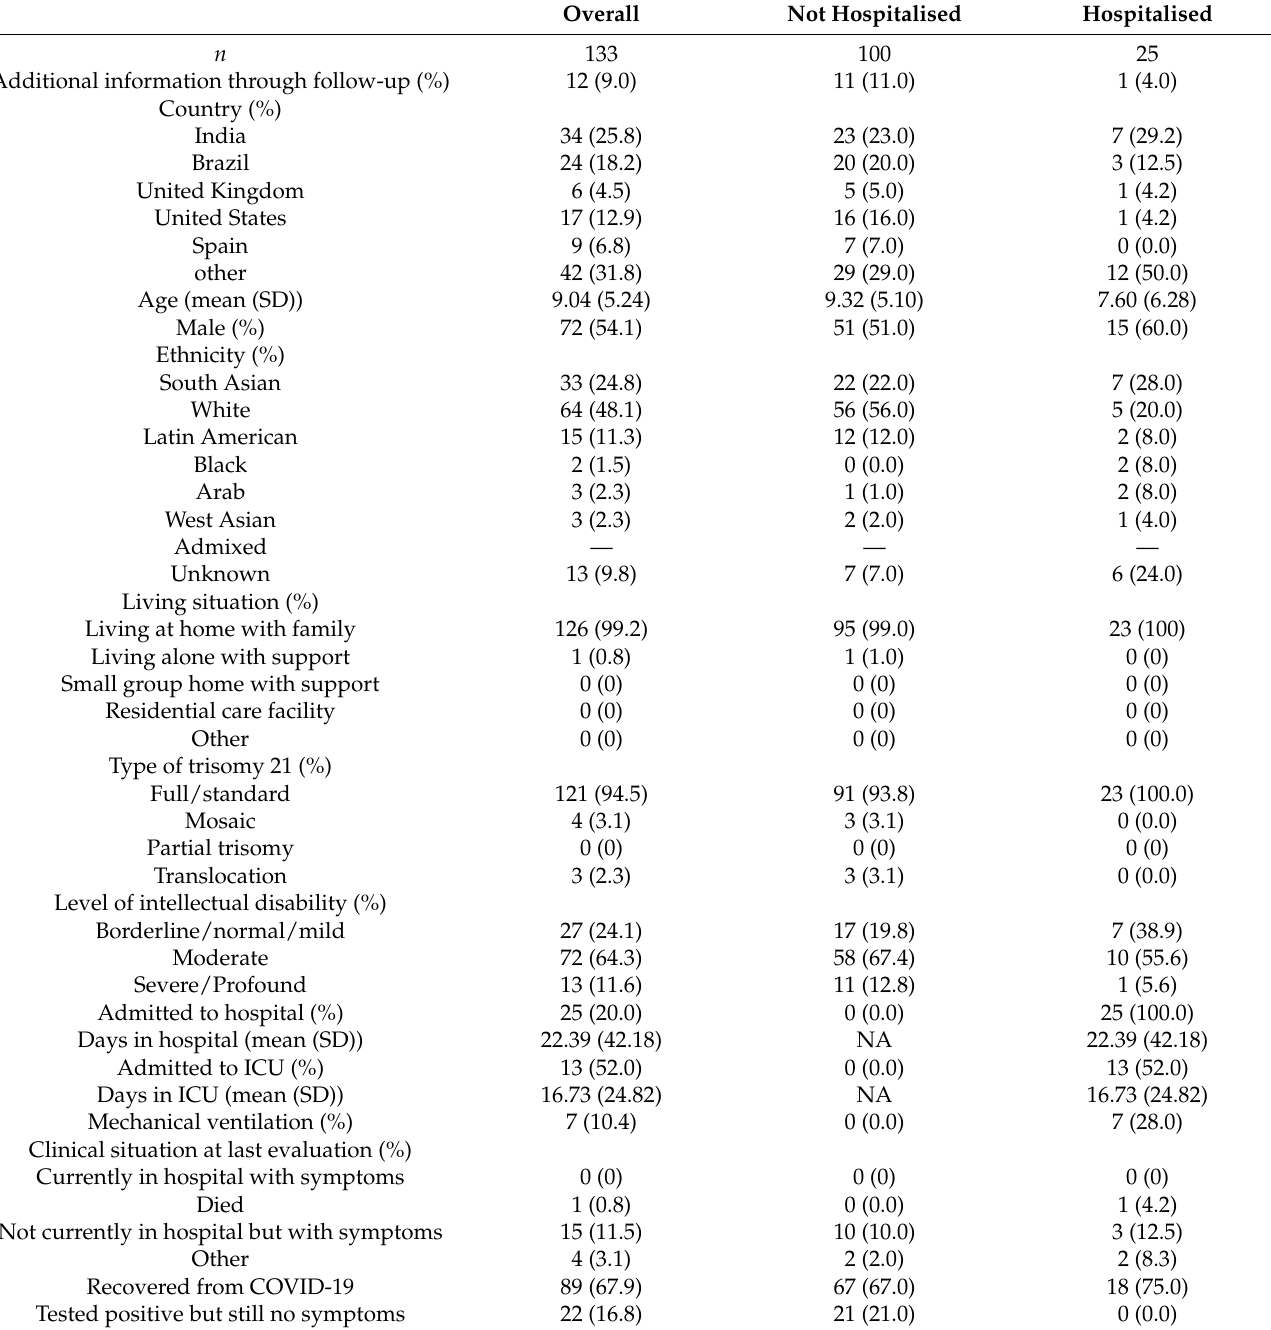
Table A5. Data entered into the database during a later phase of the pandemic (22 October to 2 August 2021). T21RS study characteristics grouped by hospital